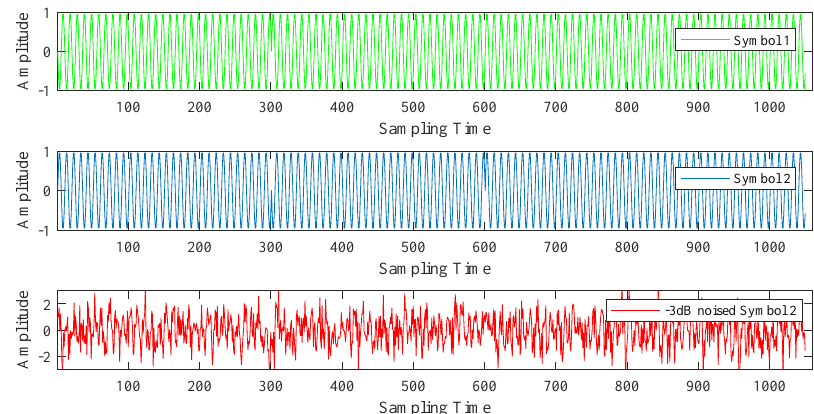
Figure 4. The improved 2PPSK illustrations in the